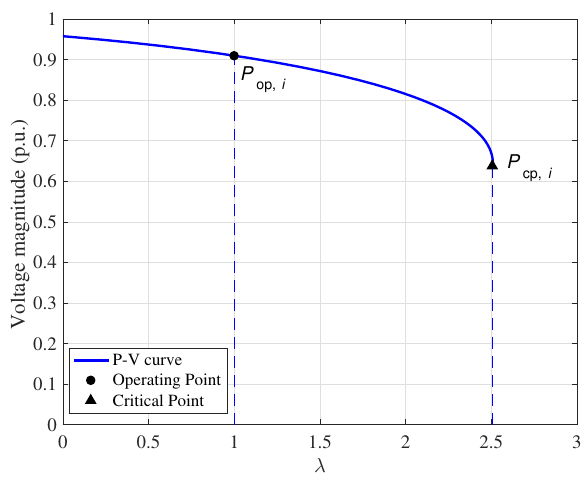
Figure 2. P–V nose curve: It illustrates the relation between voltage magnitude change and real power variation at one bus. λ represents the continuous variation of real power at the bus, which can be transformed into real power injection at this